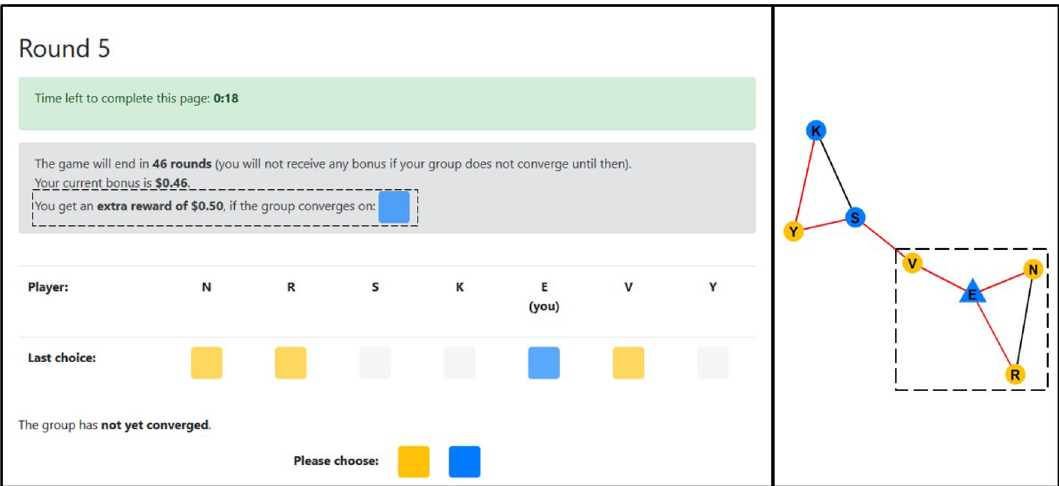
Figure 1. An example task screen (left) and the underlying network structure of the task (right). Left: A horizontal array of colored boxes represents the choices made in the last round. The choices of players not neighboring in the network are greyed out. In the example, players V, N, and R are visible to focal player E, who has been assigned the target to sway the group to blue. Only individuals incentivized to be opinionated about a specific target color saw the information about the extra reward and target color (dashed box). Right: Visualization of the underlying network structure. Note that this information was NOT visible to players. Node colors represent players’ choices in the last round, and the triangle node shape represents the incentivized